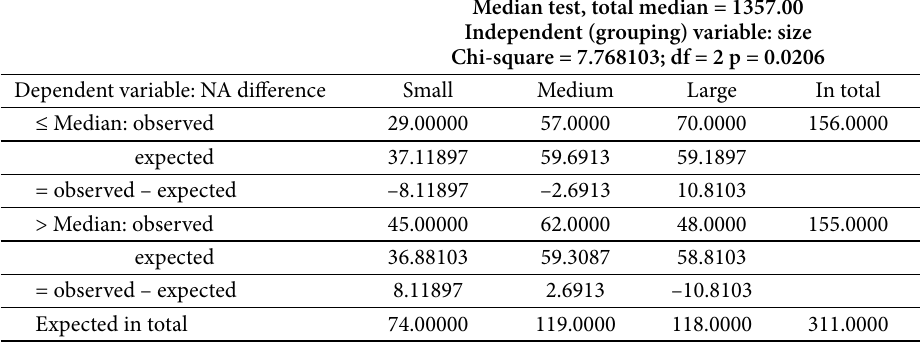
Table 8. Median test of NA difference before and after the merger by size categories Median test, total median = 1357.00 Independent (grouping) variable: